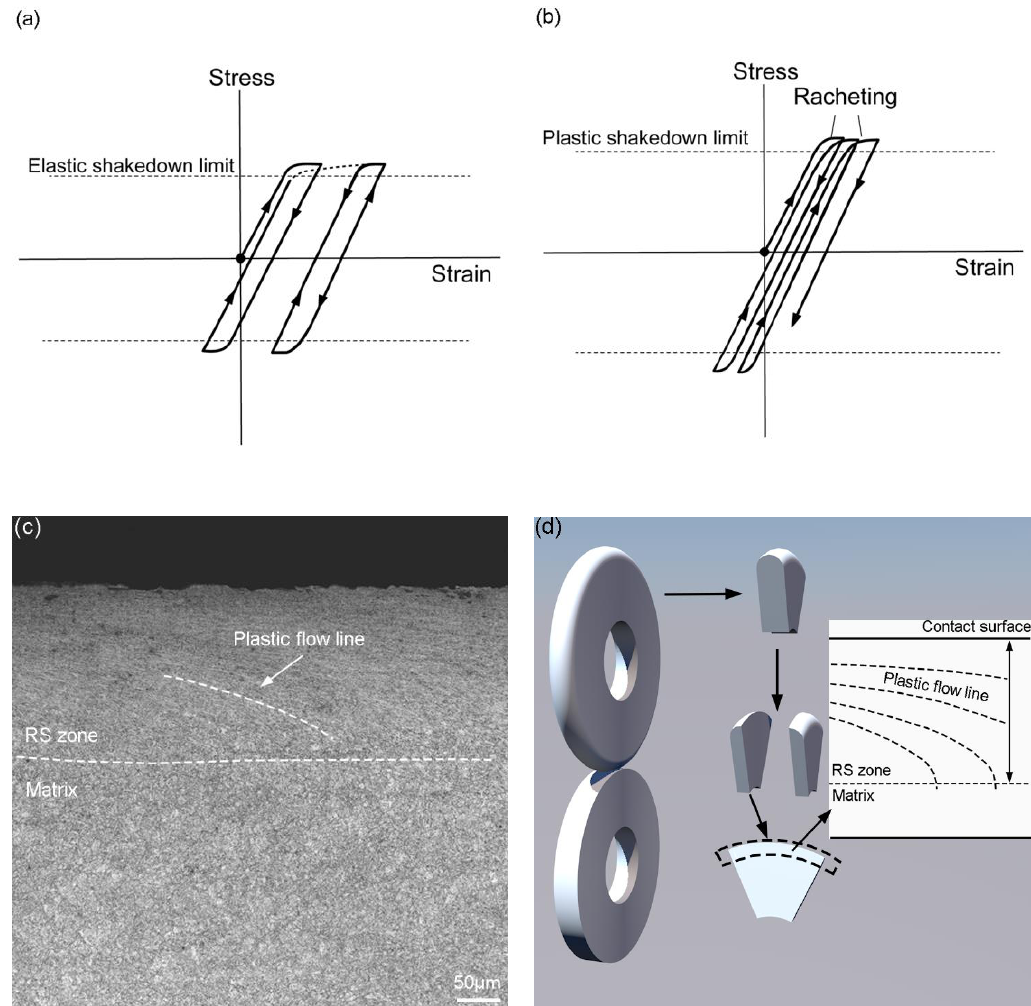
Figure 5. ( a , b ) Various forms of structural response to cyclic loading, ( c ) OM image of the longitudinal section of wear sample, and ( d ) schematic diagram of specimen cutting and the RS zone.